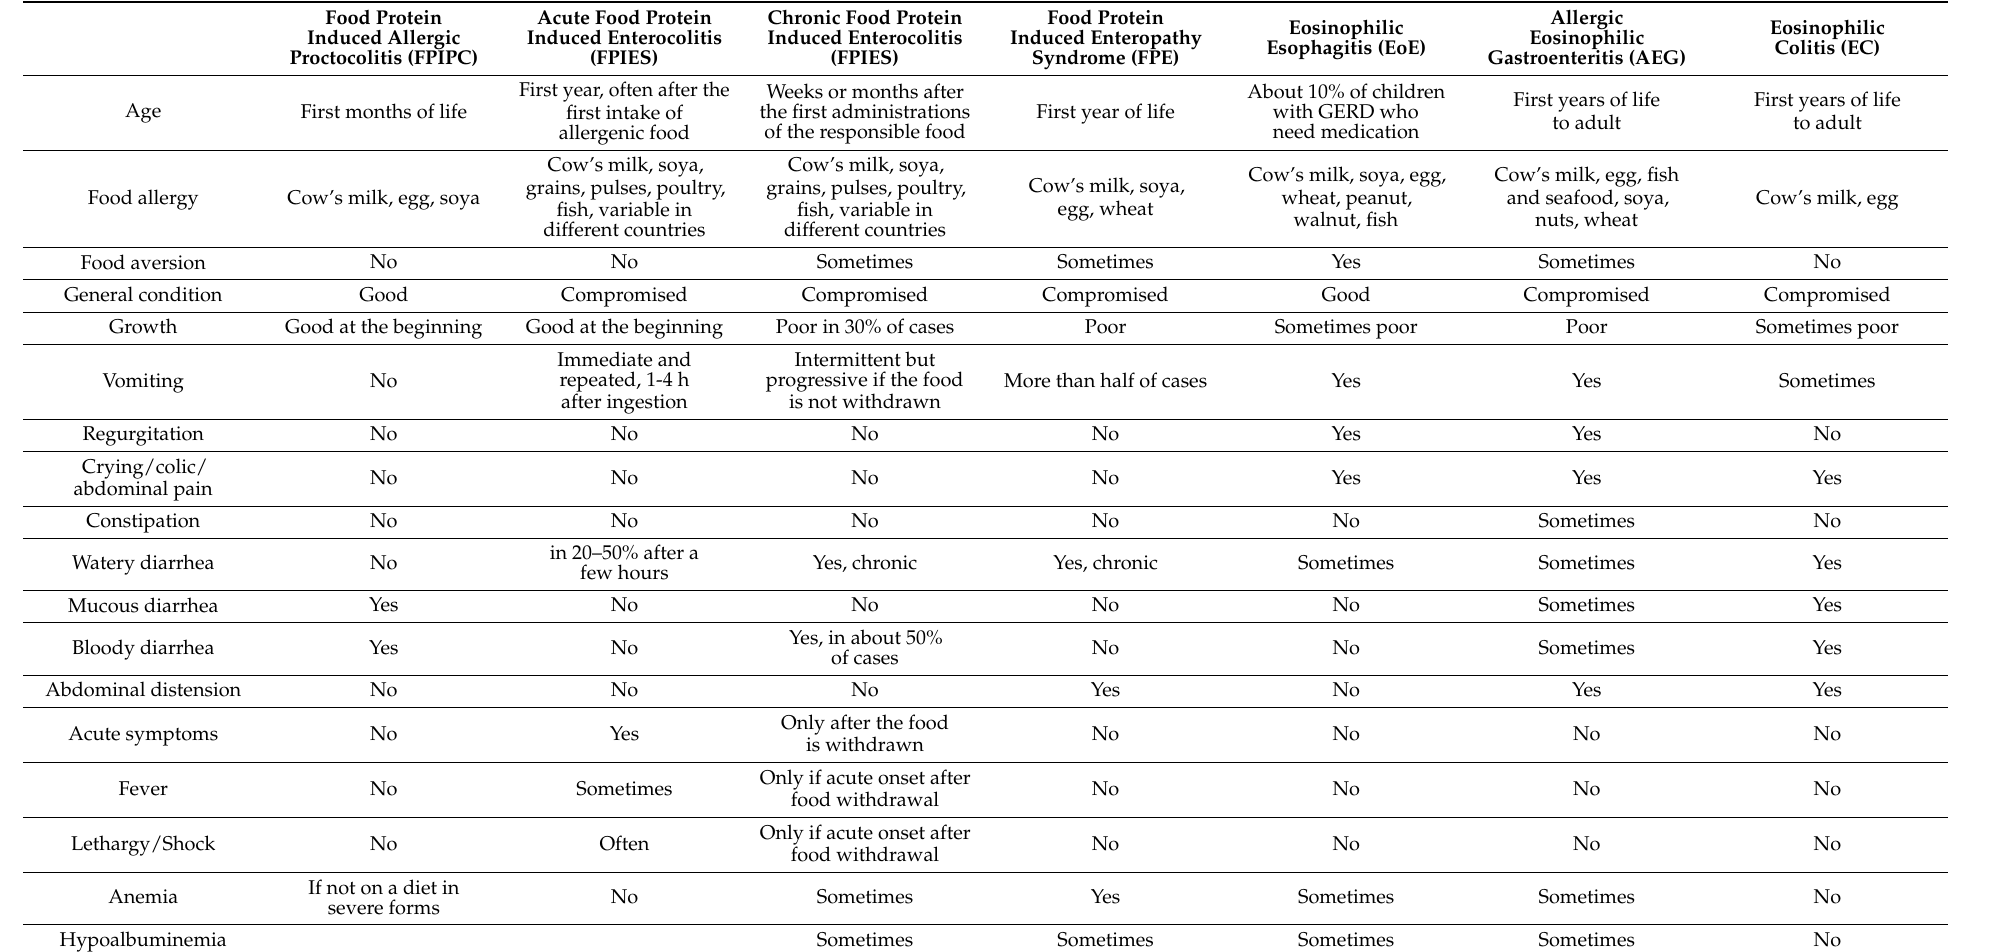
Table 1. Clinical features of Non–IgE- or Mixed IgE/non–IgE-mediated Gastrointestinal Food